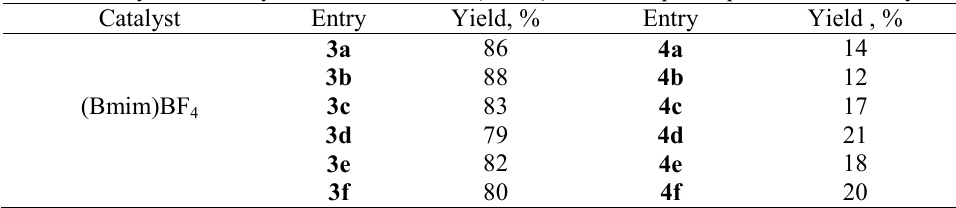
Table 2. Alkylation of 5-cyano-indazole 2 in absence of (Bmim)BF